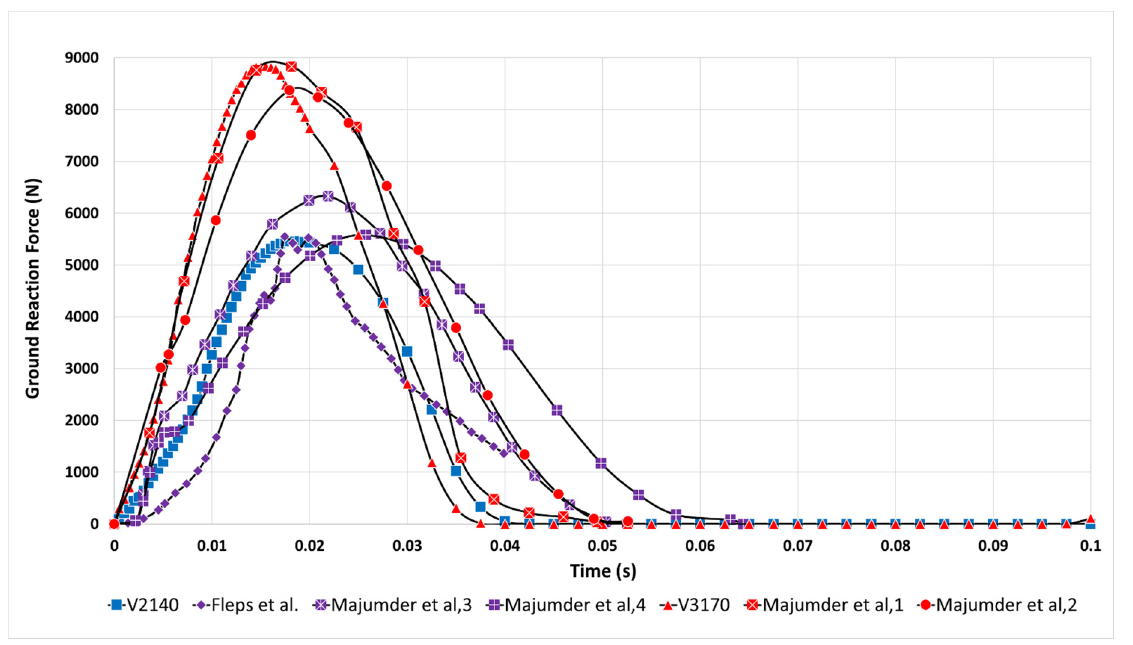
Figure A6. Ground reaction force (GRF): current study (V impact = 2140 and 3170 mm/s) vs. Fleps et al. [13] and Majumder et al. [45,72] for sideways fall experiments. Table A4. GRF max : current study vs. previous studies.